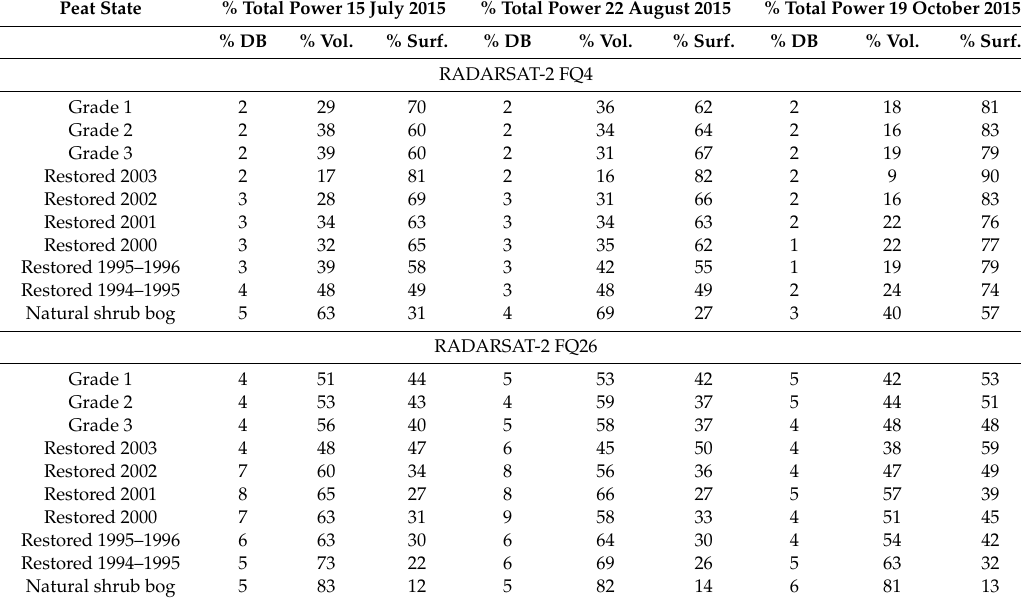
Table 5. The total power contributions from the Freeman–Durden decomposition. DB represents the percent of total power resulting from double-bounce backscatter, vol. the percent of total power from volume backscatter, and surf. the percent of total power from surface backscatter.